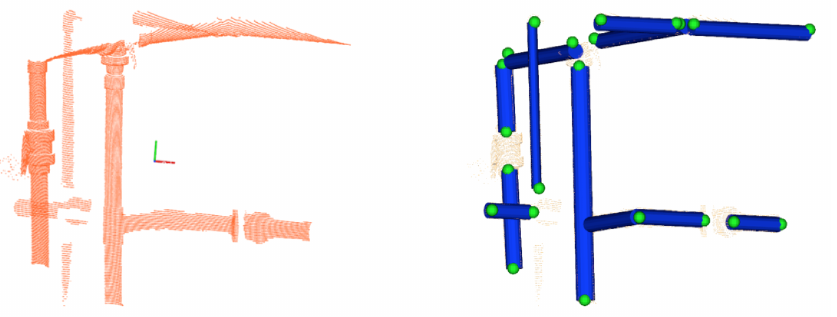
Figure 3. Pipes detection: ( left ) 3D laser scan point cloud; ( right ) pipes with their respective endpoints.